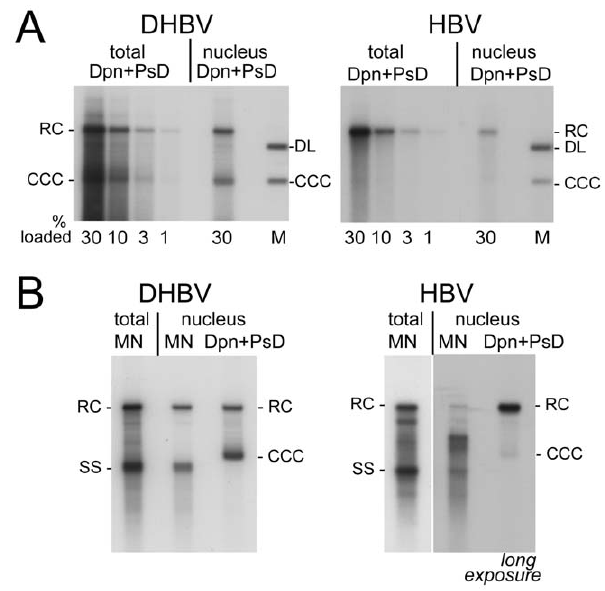
Figure 4. Intracellular distribution and nuclease sensitivity of viral DNAs. HepG2 cells were transfected with vectors for surface- deficient DHBV (left panels) or HBV (right panels). ( A ) Relative nuclear distribution. DNA was extracted, after prior PK treatment, from total cells or from gradient-purified nuclei and subsequently digested with DpnI plus PsD. Serially diluted samples were loaded on the gel. Loading volumes are indicated in percent of the total sample volume, obtained from one well of a 6-well plate. One of three experiments used for quantification (see text for details) is shown. ( B ) Direct comparison of MN resistant versus total nuclear viral DNA. DNA was prepared from total cell extract treated with MN plus PK (MN), or from gradient- purified nuclei; equal aliquots of the nuclei were treated with MN plus PK before DNA extraction (MN), or with only PK followed by incubation with Dpn I plus PsD (total nuclear DNA). A six times longer exposure for the nuclear HBV samples is shown to better reveal weak signals. Quantification indicated that only , 10% of the nuclear full-length HBV versus $ 80% of the nuclear DHBV DNA were MN resistant.